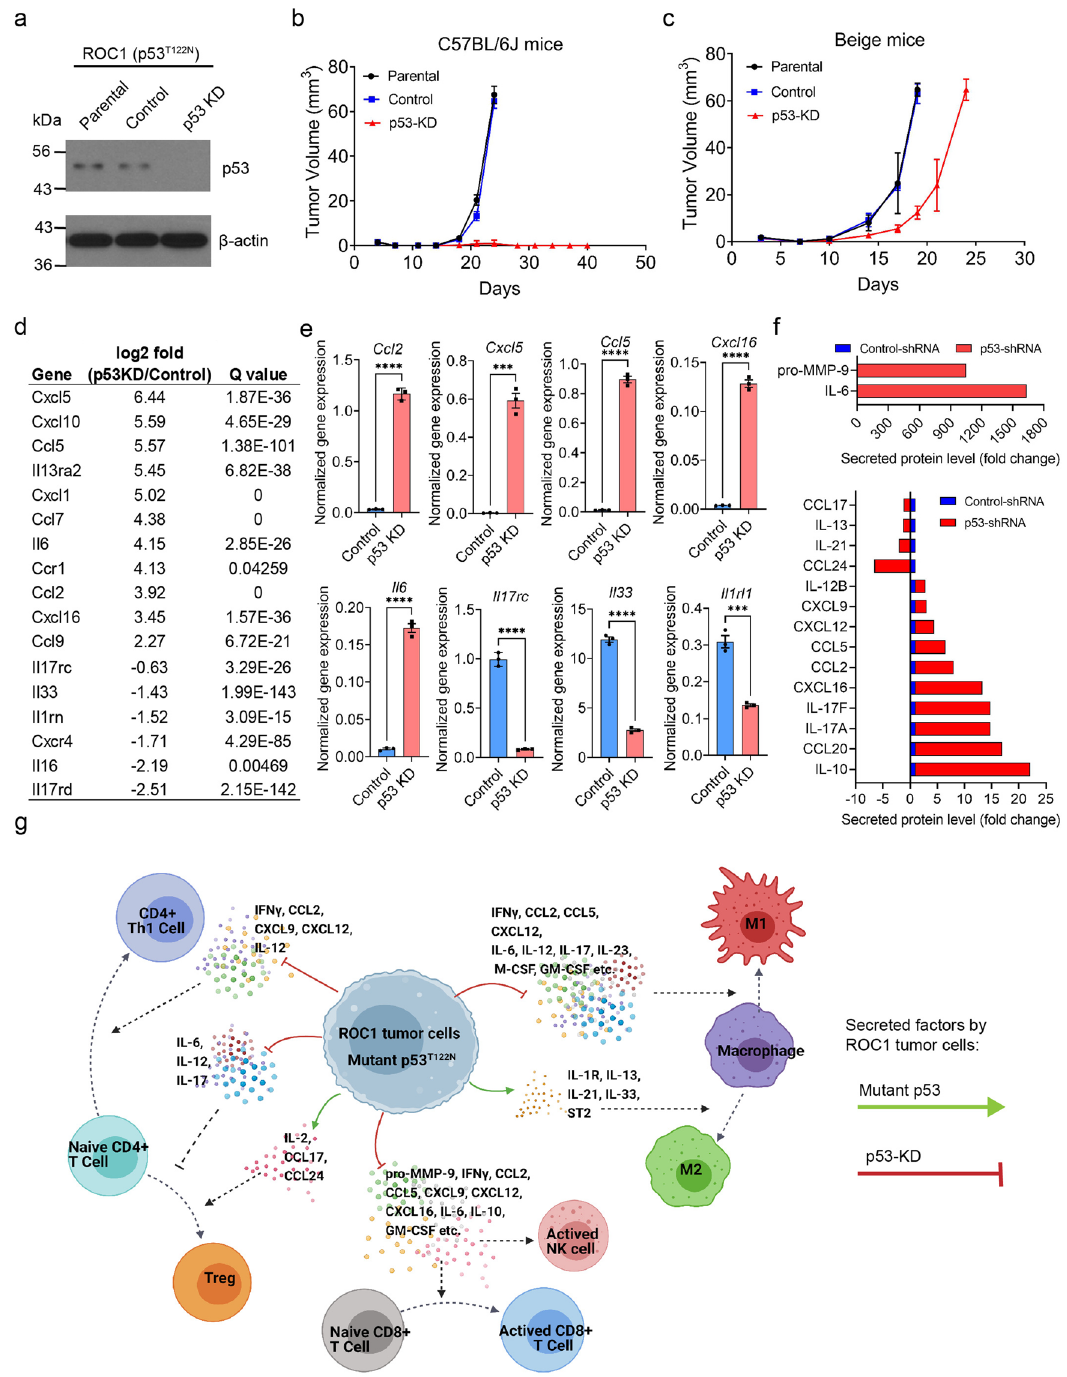
Fig. 4 Mutant p53 in ROC1 tumors modulates tumor cell-intrinsic factors required for immune escape in immunocompetent mice. a Western blot analysis of the parental, Control (Non-Targeting Control-shRNA), and p53-KD (p53-shRNA) clones. β -actin was used as a loading control. b , c ROC1 cells (50,000) were implanted into the tongues of C57BL/6J mice ( n = 5) and immunode fi cient beige mice ( n = 5) respectively, KD of mutant p53 impairs tumor growth in immune competent mice ( b ) compared with immune de fi cient Beige mice ( c ) (error bars = standard deviation). d Differential chemokine and cytokine gene expression analysis of ROC1 p53-KD cells relative to control cells, showing genes with signi fi cant Q values. e Validation of cytokine and chemokine RNA expression by qPCR (Bar = mean of triplicate experiment, error bars = standard error mean). Unpaired two-tailed Student ’ s t test p -values shown, *** P < 0.0005, **** P < 0.0001, for comparison of control vs p53-KD ROC1-tumor cells. f Fold changes in mouse cytokine protein expression in p53- KD tumor cells relative to control tumor cells. Antibody array assay was used to measure cytokine levels from an equal amount of supernatant of 48-h culture (details in Material and methods section). The bars represent the average of duplicate independent experiment for comparison of control vs p53- KD ROC1 cell supernatants. g Proposed molecular model by which mutant p53 regulates the TIME. ROC1 cells acquire a carcinogen-induced mutation in p53, yielding cytokines that promote M2 macrophage polarization and the in fi ltration of Tregs, thereby generating an immunosuppressive TIME by excluding effector immune cells. Created with